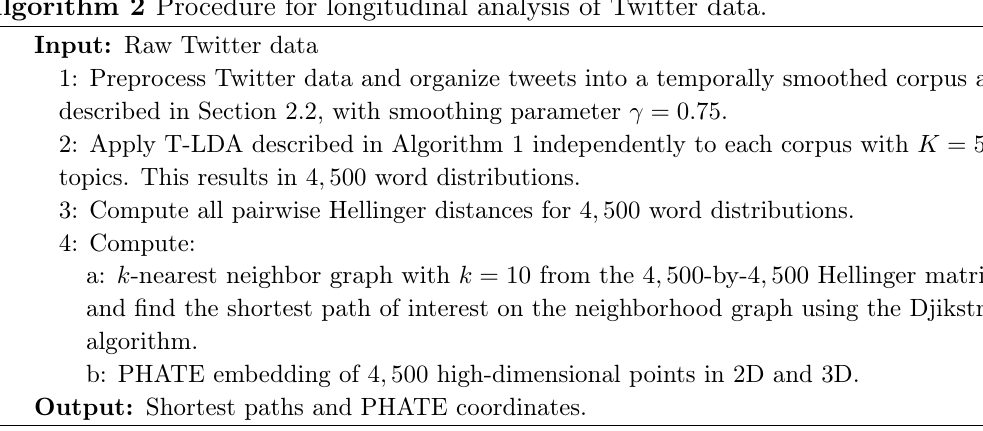
Algorithm 2 Procedure for longitudinal analysis of Twitter